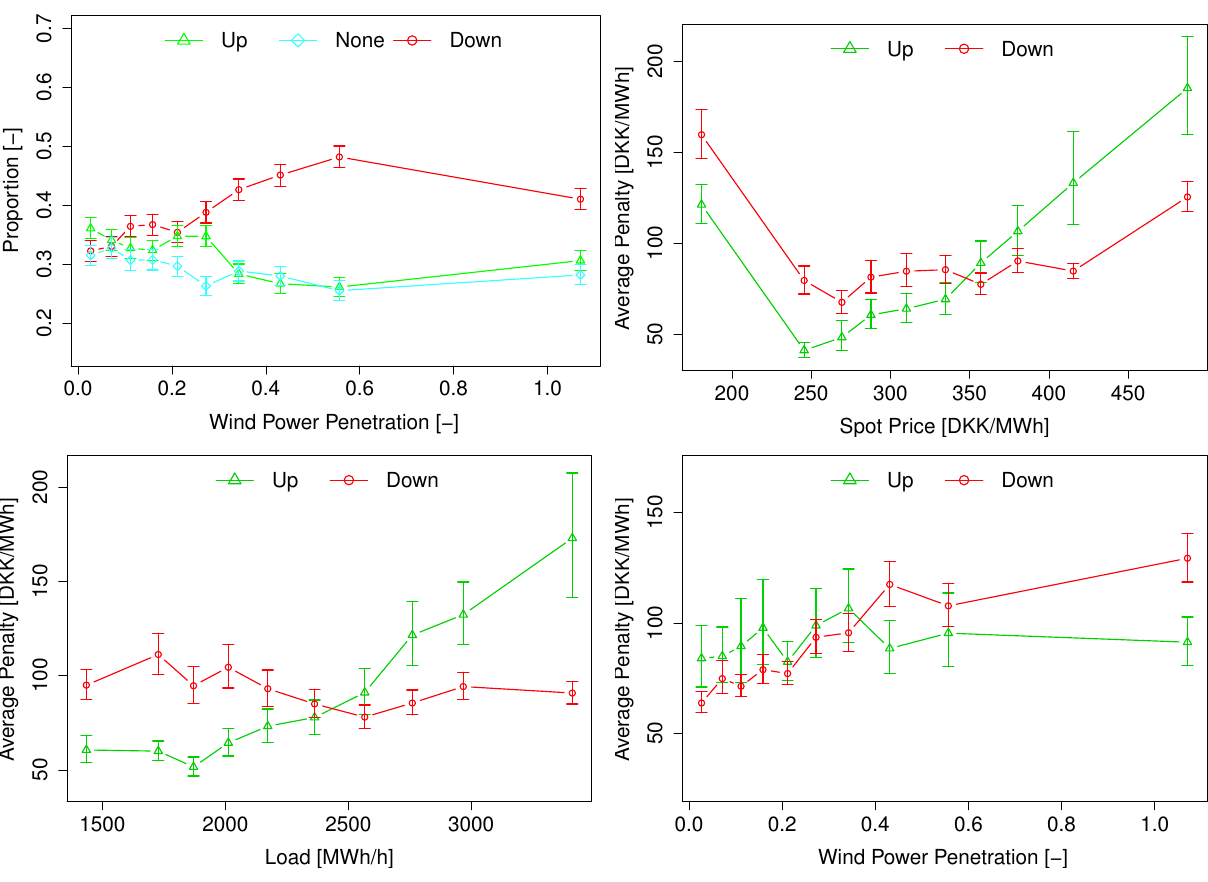
Figure 4. The empirical frequency of each imbalance sign as a function of predicted wind power penetration ( top left ) and average imbalance penalties as a function of predicted spot price ( top right ), predicted load ( bottom left ) and predicted wind power penetration ( bottom right